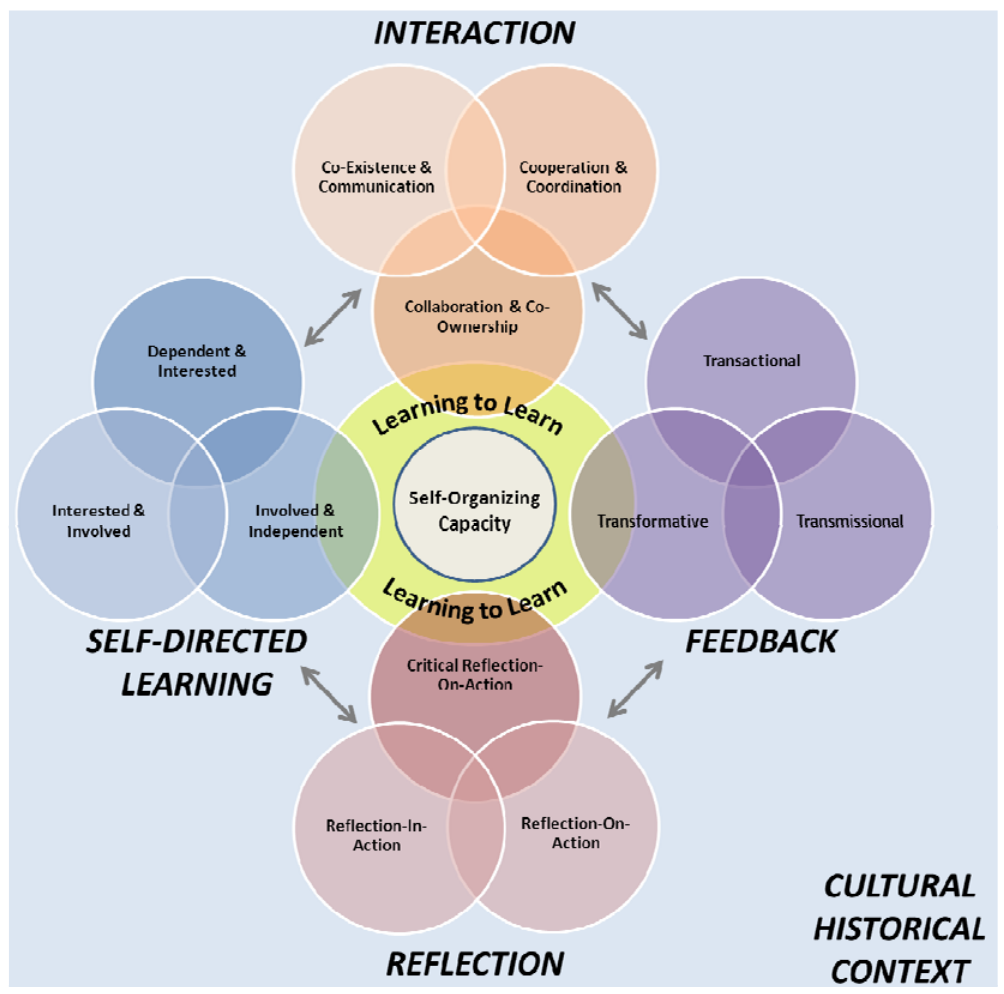
Figure 1. Learning to Learn (L2L): A Conceptual Model of Learning Behaviours and Conditions that Contribute to the Self-Organizing Capacity of Care Systems. There are interconnections between all L2L behaviours and conditions (not all shown).